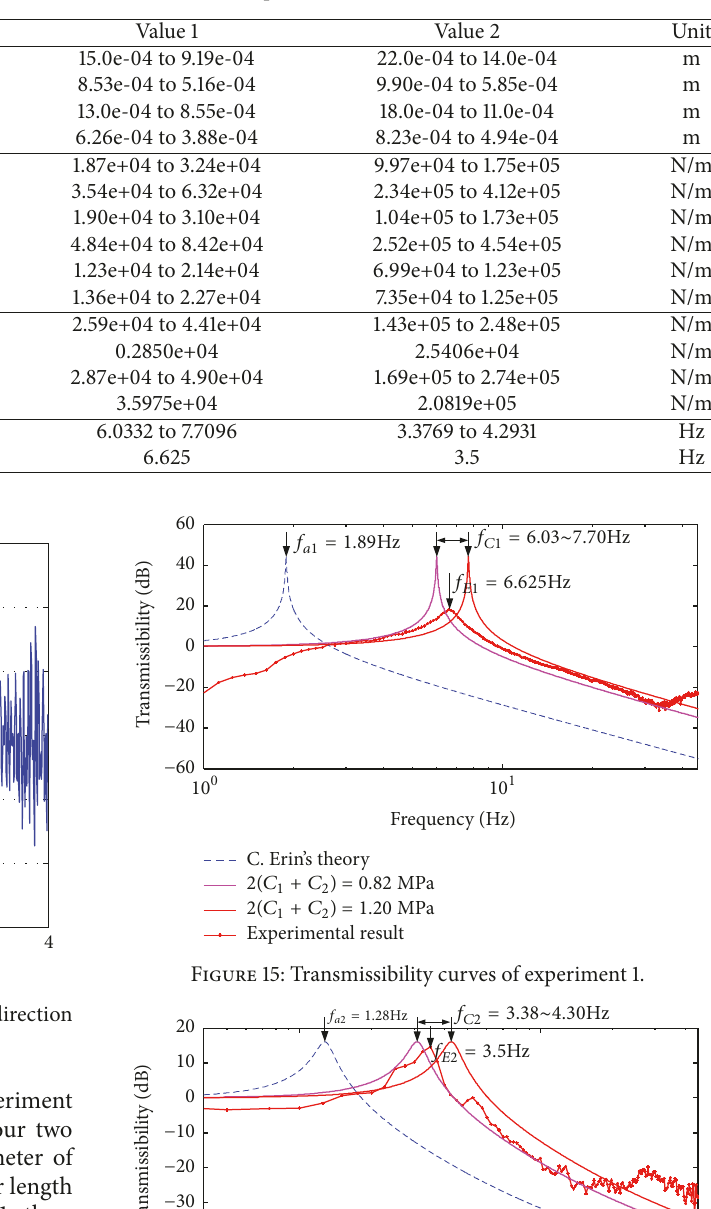
Table 3: Stiffnesses from the calculations and experiments.